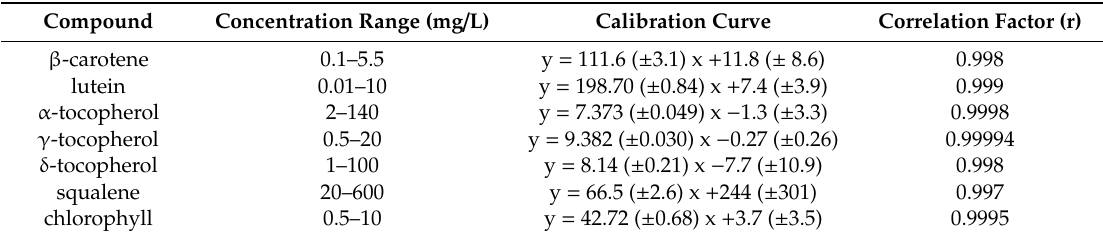
Table 2. Calibration curves and correlation factors for each analyte.